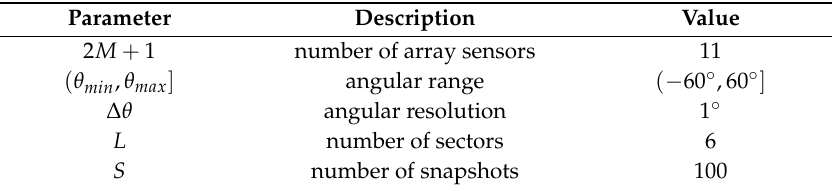
Table 1. Parameters in regard to simulation conditions.